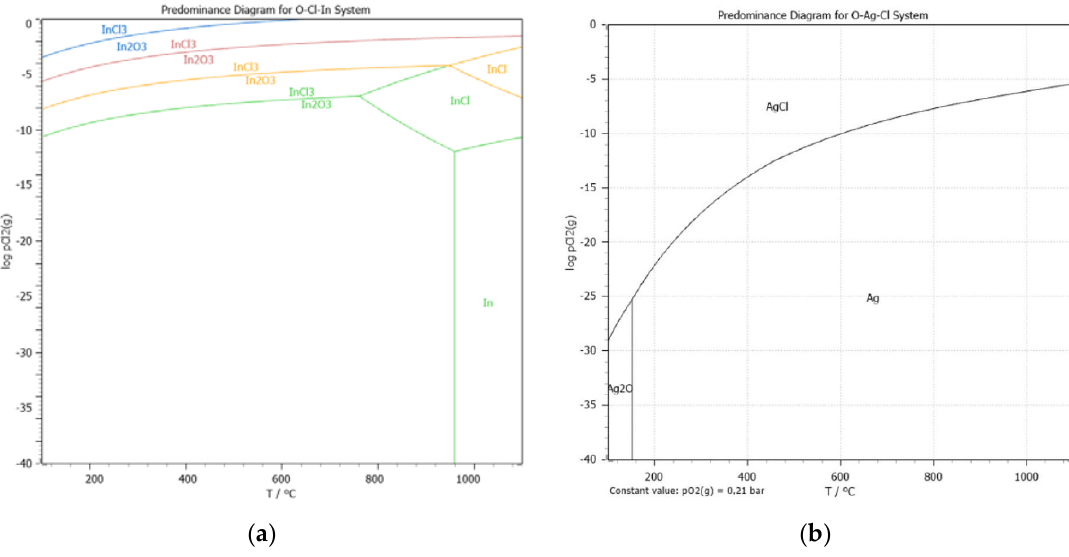
Figure 3. ( a ) Predominance diagram (Tpp) for the system O-Cl-In at four O 2(g) partial pressures (green: 1 × 10 −15 bar; yellow: 1 × 10 −10 bar; red: 1 × 10 −5 bar; blue: 0.21 bar;) ( b ) Predominance diagram (Tpp) for the system O-Cl-Ag at a O 2(g) partial pressures of 0.21 bar. (Tpp) for the system O-Cl-Ag at a O 2(g) partial pressures of 0.21